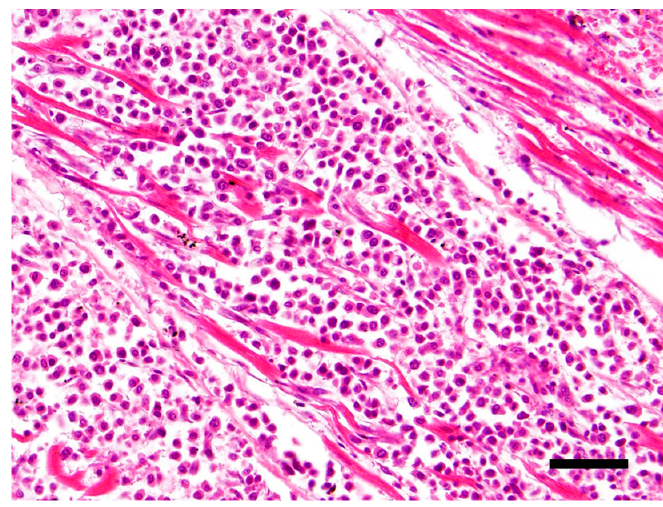
Figure 1. Effacement of the myocardial architecture by an invasive population of round cells that separate degenerating myofibers. Hematoxylin and eosin (H&E) stain 40×, Bar = 50µm.